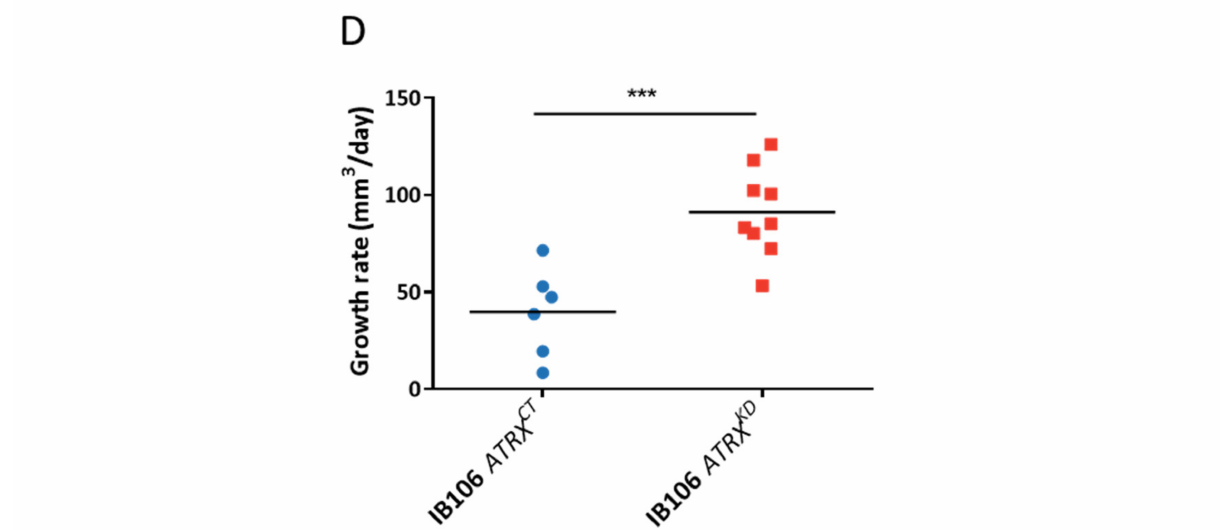
Figure 5. ATRX knock-down increases the aggressiveness of sarcoma cells. ( A ) ATRX knock-down by shRNA validation in western blot in K7M2, MG63, and IB106 cell lines. ( B ) Proliferation analysis by MTT after four days, comparing ATRX CT and ATRX KD cells in K7M2, MG63, and IB106 cell lines (mean ± s.d.; n = 3 independent experiments). ( C ) Soft agar assay analysis comparing ATRX CT and ATRX KD cells in K7M2, MG63, and IB106 cell lines (mean ± s.d.; n = four independent experiments). Images were taken after four weeks and crystal violet staining. ( D ) Tumor growth rate analysis of IB106 ATRX CT or IB106 ATRX KD cells sub-cutaneous xenografts on NSG mice ( n = 10 in each group). The growth rate was calculated by segmental linear regression with GraphPad. * p ≤ 0.05, ** p ≤ 0.01, *** p ≤ 0.001, p -value was calculated with 2-way ANOVA for ( A ) and unpaired t -test for ( B – D